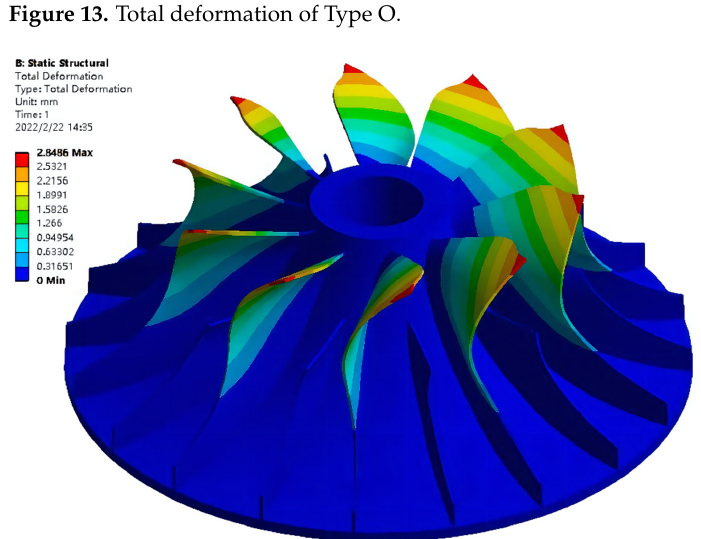
Figure 13. Total deformation of Type O.